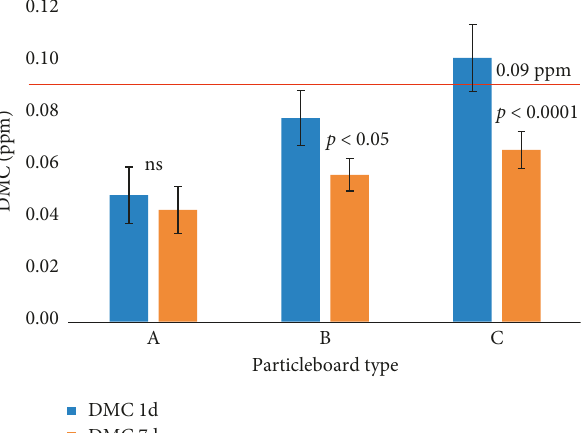
Figure 5: Formaldehyde emissions measured using DMC after one day and seven days from the production of particleboard types (A, B, and C) The EPA TSCA Title VI level of 0.09ppm for particleboards is marked in the graph. Bars represent mean values of sample determinations for different production batches (7 for A, 8 for B, and 19 for C), and the error bars represent standard deviations. Significance of differences between 1- and 7-day mean values for each board type is marked above the